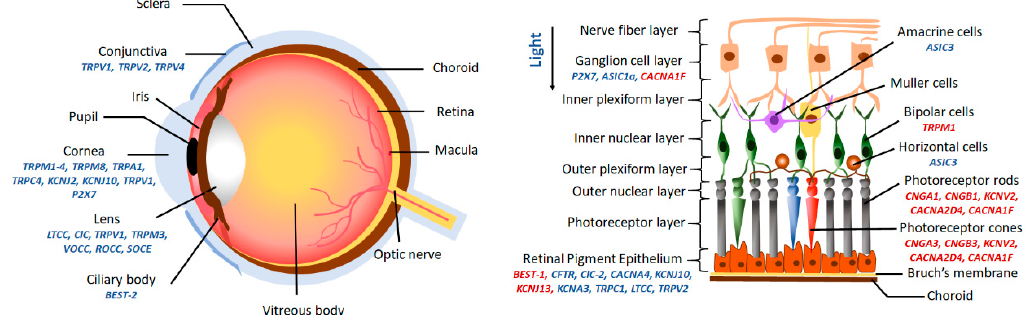
Figure 2. Anatomical location of ocular ion channels. Channels highlighted in the red cause associated blindness due to mutations.